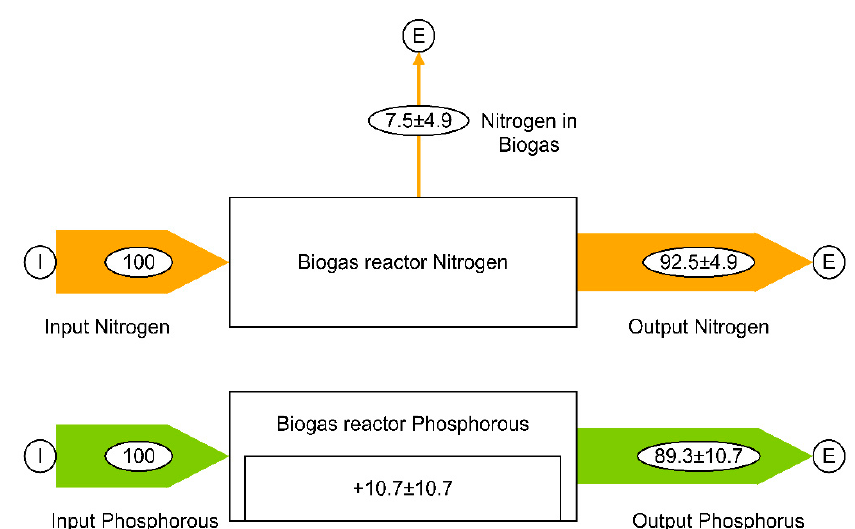
Figure 3. Calculated mass balance of N and P in percent, relative to the input amount. N is assumed to be released in the the gas phase; P is assumed to remain in the digesters as it forms crystals with other elements. The standard deviation of the mean is displayed as “±”. The results of 12 [37,46–49] and 14 [37,45–49] experiments are used to calculate the average RR of N and P, respectively.